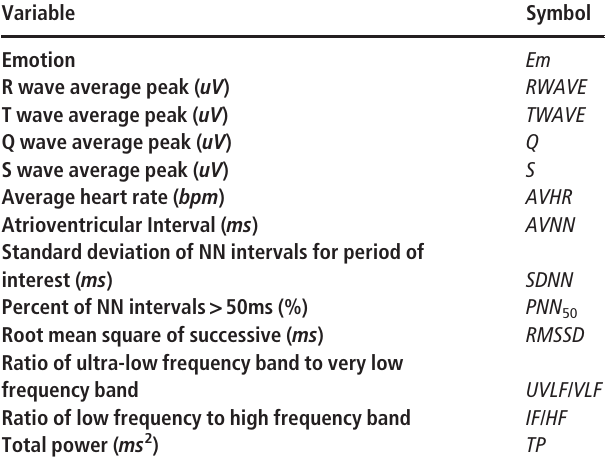
Table V Variables and symbols for ECG signals